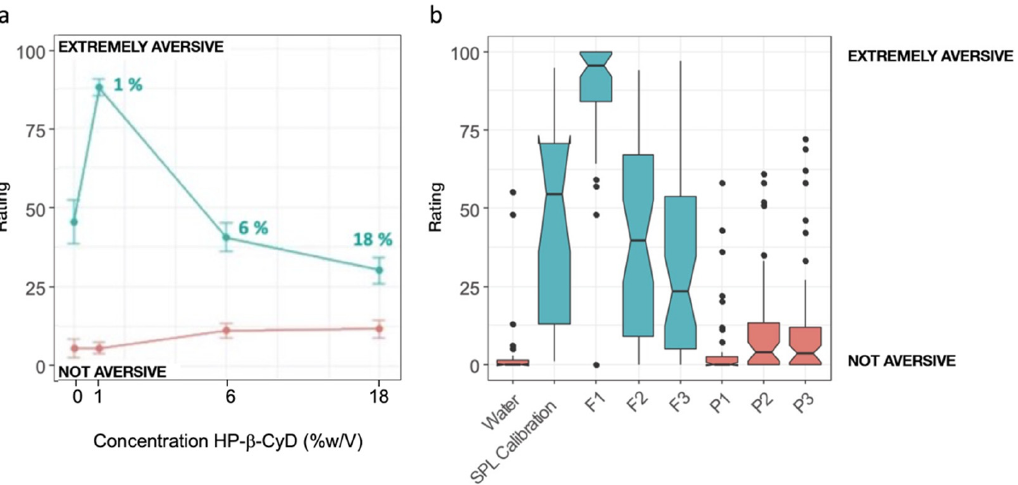
Figure 6. ( a ) Average aversiveness ratings (±the standard error of the mean, SEM) as a function of HP- β -CyD solutions with SPL (F1, F2, F3) in blue and their corresponding placebos (P1, P2, P3) in red; ( b ) boxplots representing taste ratings as a function of HP- β -CyD concentration for SPL solu- tions with HP- β -CyD and their corresponding